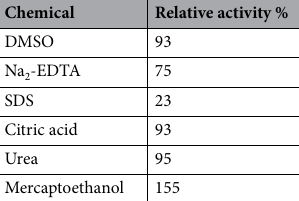
Table 3. Effect of chemicals on activity of xylanase